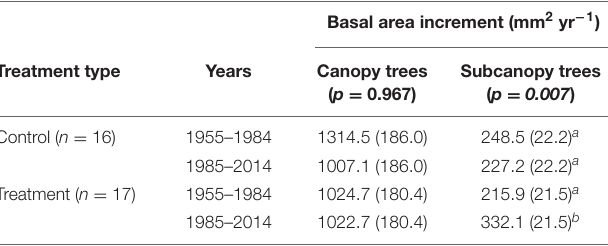
TABLE 2 | Effect of harvesting on basal area increments of canopy and subcanopy